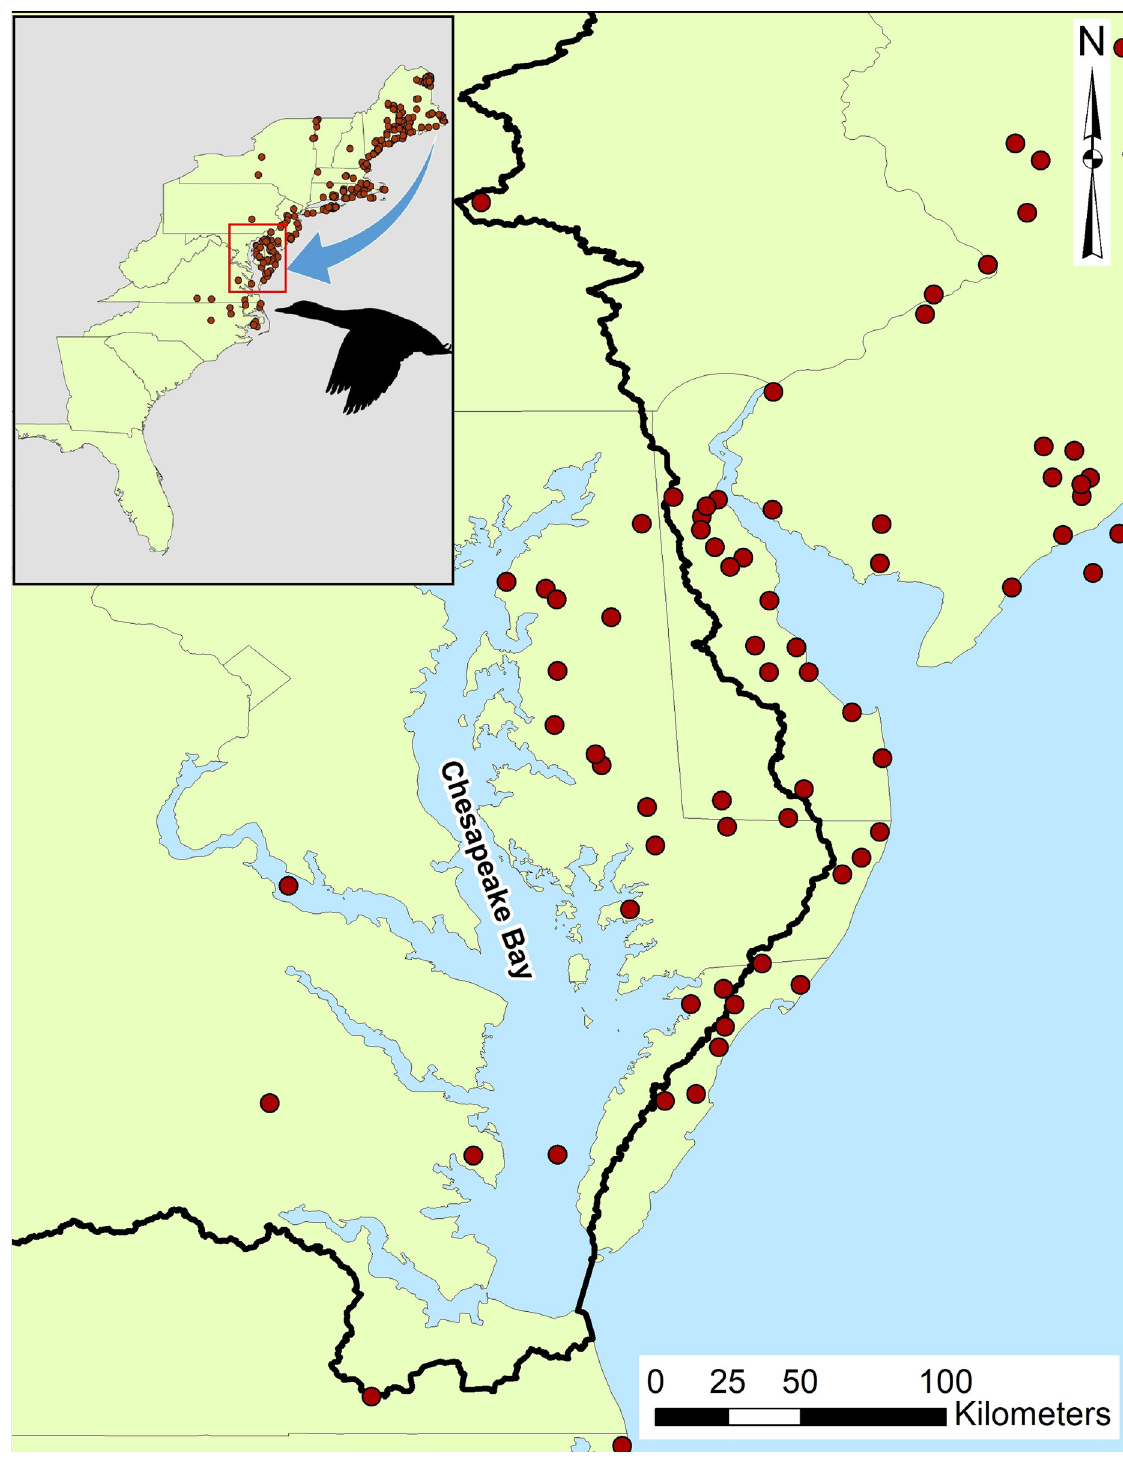
Fig 1. Waterfowl migratory connectivity. Within-season migratory connections between sampling areas within the North Atlantic migratory flyway (Maine, Maryland, respectively) shown as re-encounter locations for two primary waterfowl species: mallard and American black duck. Data obtained for a 10-year period (2011 through 2021) from the North American Bird Banding Program. Red dots indicate birds banded in Maine and re-encountered in the same migratory season (for example, potentially bred in Maine and wintered in Maryland). The black line indicates the extent of the Chesapeake Bay watershed. Inset shows reencounter locations across the entire region